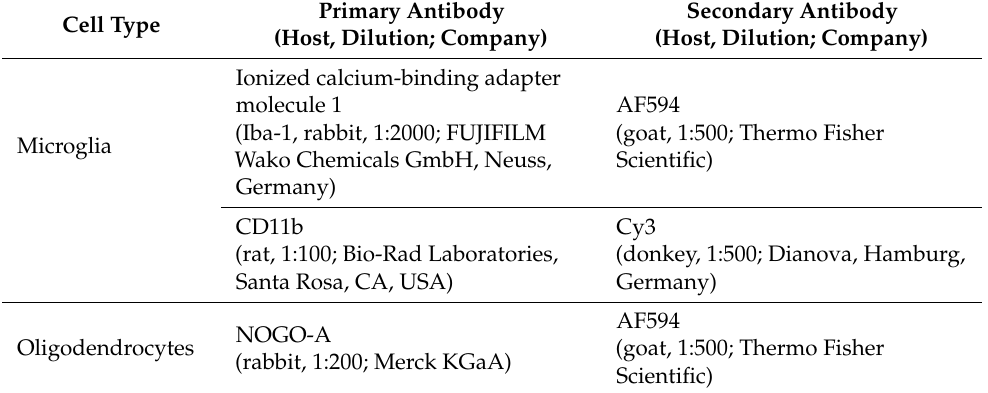
Table 4. Antibodies used for fluorescence